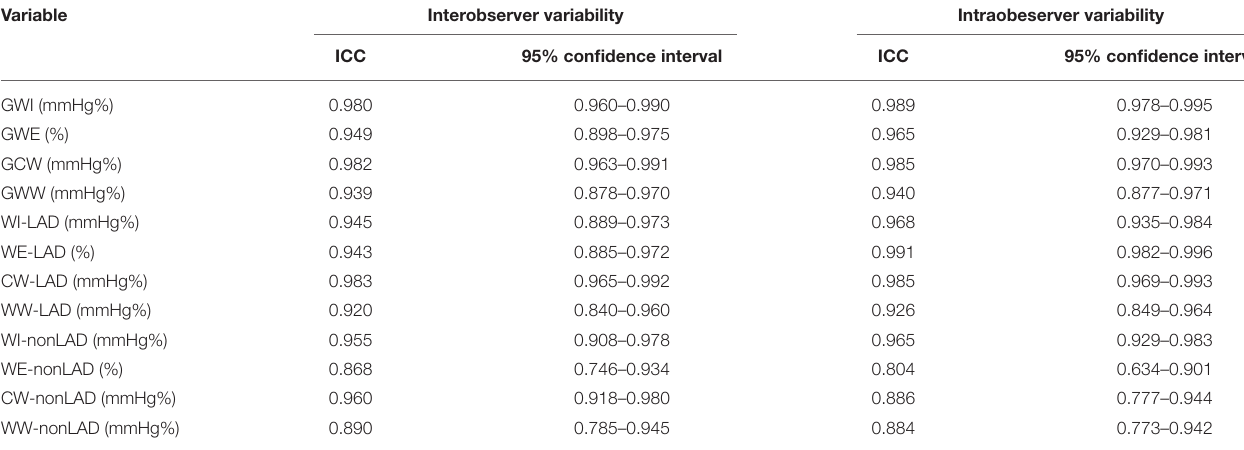
TABLE 7 | ICCs for intra- and interobserver variability for MW